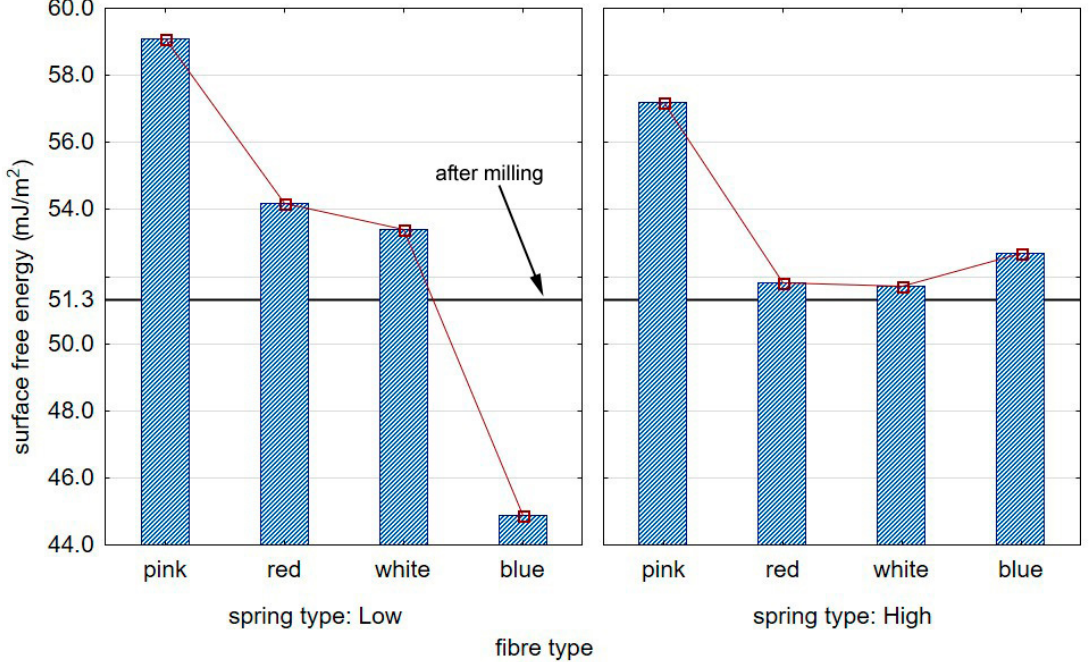
Figure 15. The impact of the brush type on the SFE (surface free energy) of the aluminium alloys.